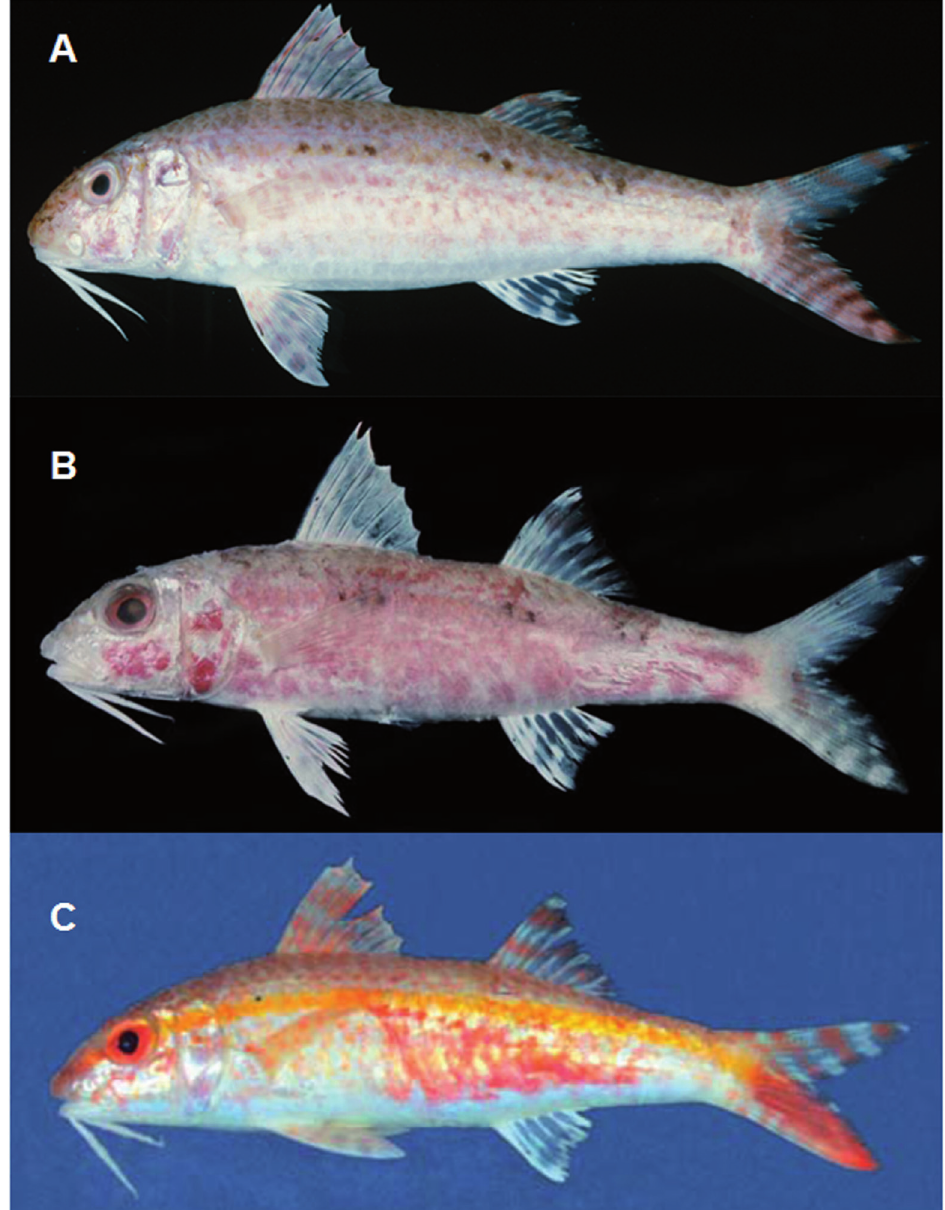
Fig . 1. – A: Upeneus randalli n. sp., holotype, BPBM 33180, SL 100 mm, Kuwait (J.E. Randall); B: Upeneus randalli n. sp., paratype, BPBM 21201, SL 80 mm, Bahrain (J.E. Randall); C: Upeneus margarethae , holotype, SAIAB 82217, SL 82 mm, Mozambique (P.C.